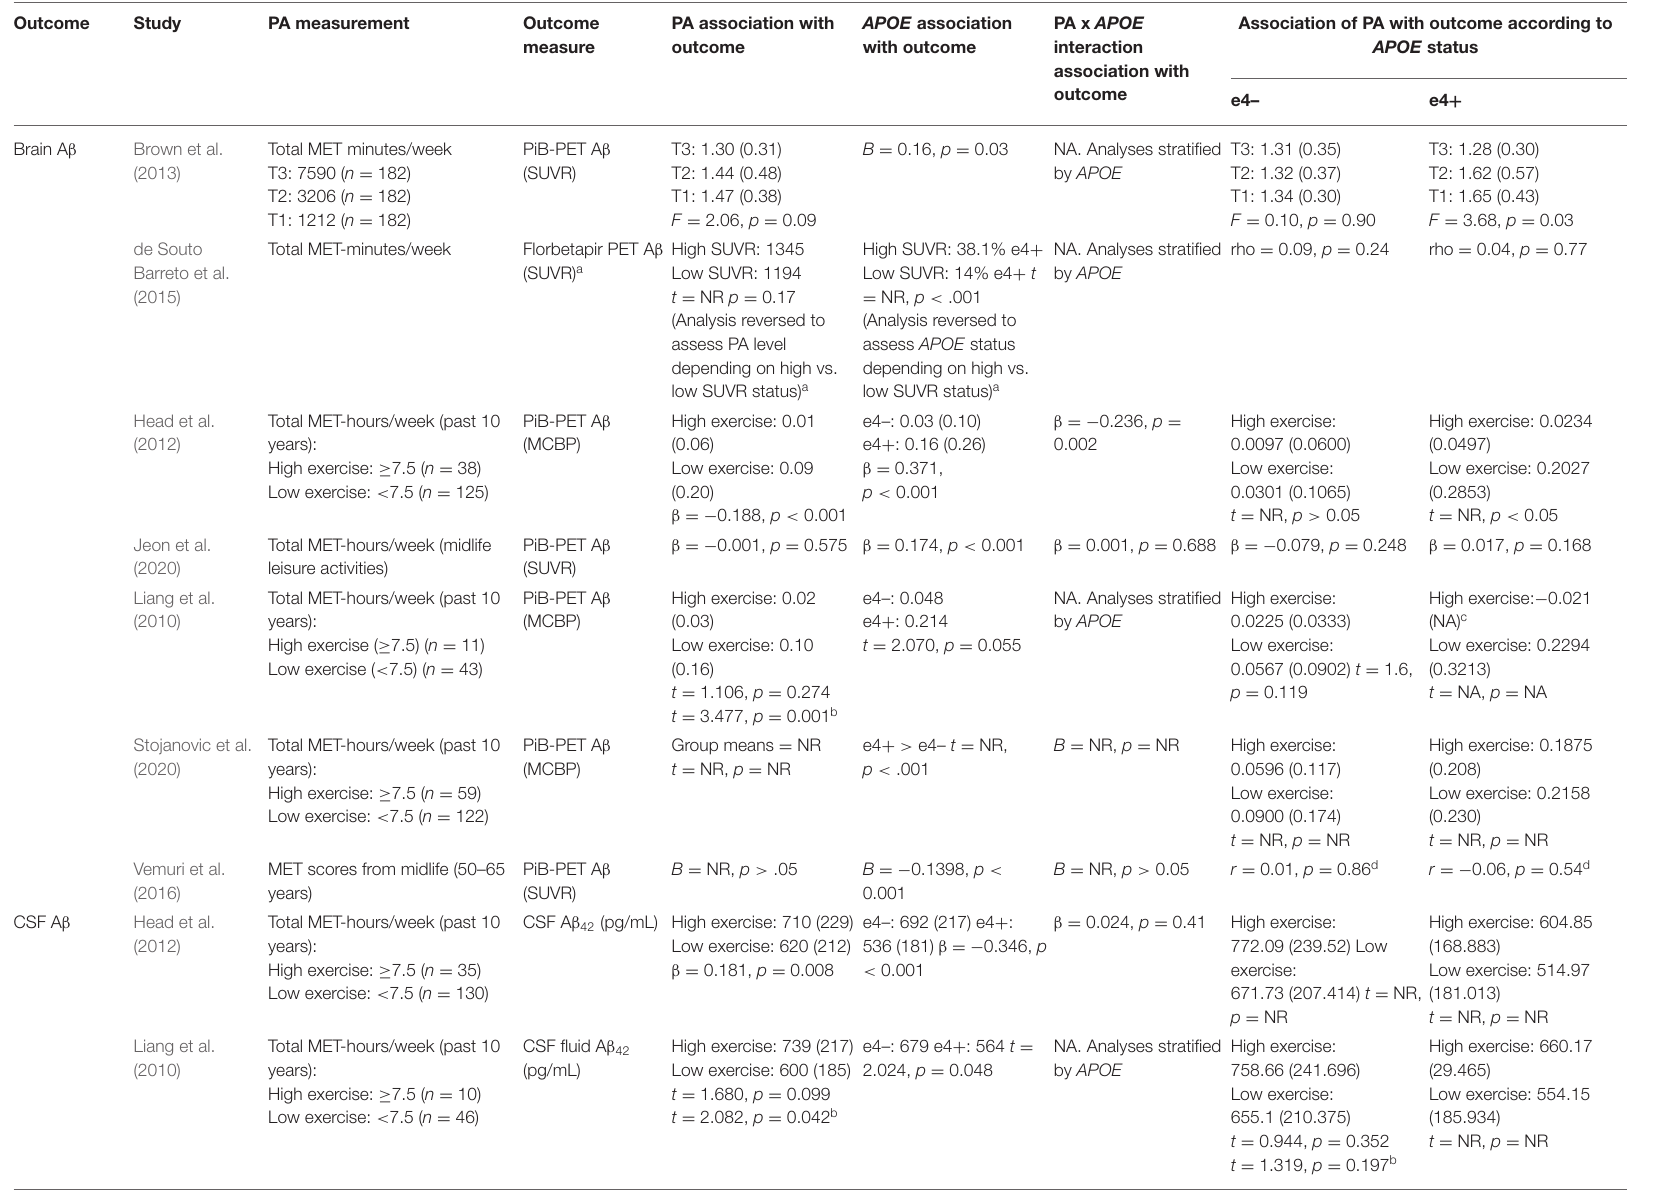
TABLE 3 | Associations between physical activity and Alzheimer’s disease